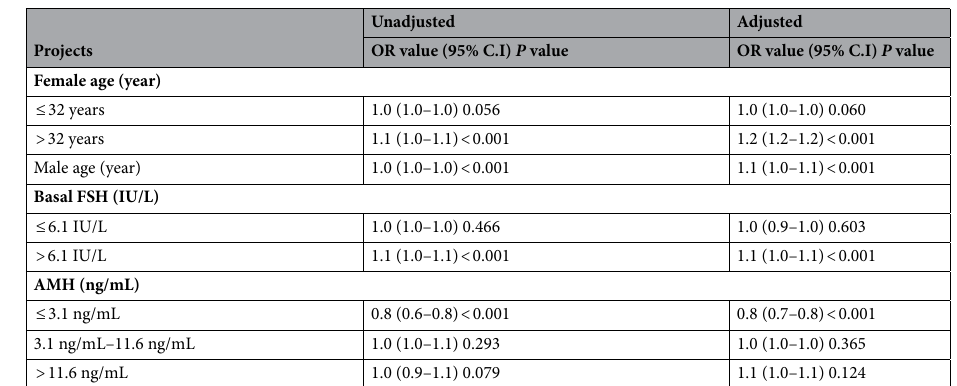
Table 3. Threshold effect analysis of spontaneous abortion using piece-wise linear regression. FSH, follicular- stimulating hormone; AMH, anti-Mulller hormones; Adjusted for female age, male age, body mass index, follicular-stimulating hormone, anti-Müllerian hormon, prolactin, number of treatment cycless, number of transferred embryos and number of fetuses except the subgroup